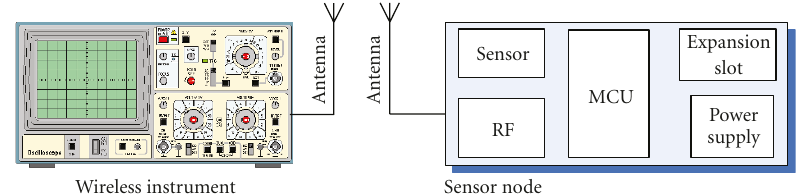
Figure 1: Gathering test data with